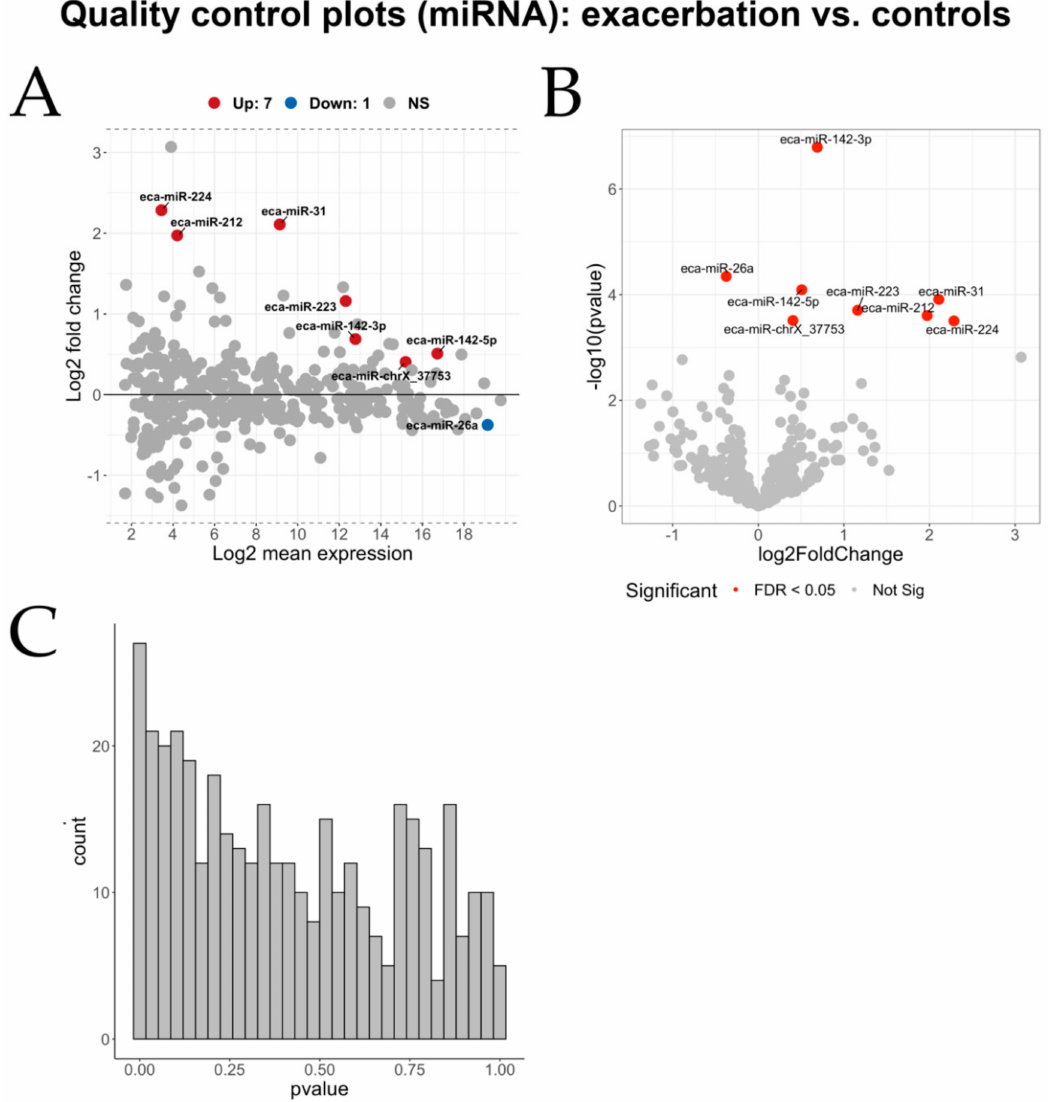
Figure A2. Quality control plots for the di ff erential miRNA expression analysis using the contrast of horses in exacerbation vs. healthy control horses. An MA-plot ( A ), a Volcano plot ( B ), and a histogram of the obtained p -values ( C ) are shown. Non-significant (NS) miRNAs are indicated in grey